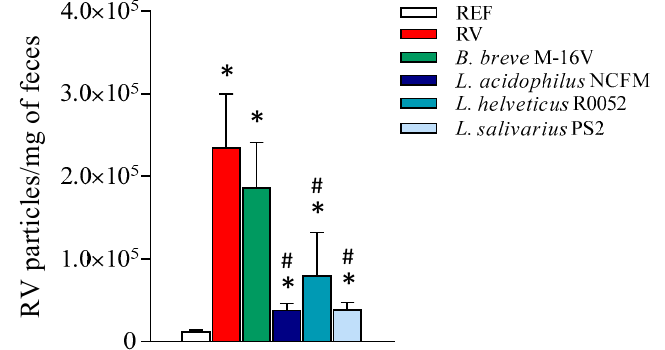
Figure 4. Fecal rotavirus elimination. The detection of rotavirus particles was performed in feces 1 DPI, which corresponded to the day of maximum elimination. Results are expressed as mean ± S.E.M. ( n = 6–10/group, depending on fecal sample availability). * p < 0.05 compared to the reference (REF) group; # p < 0.05 compared to the rotavirus (RV) group. B .: Bifidobacterium ; L .: Lactobacillus .